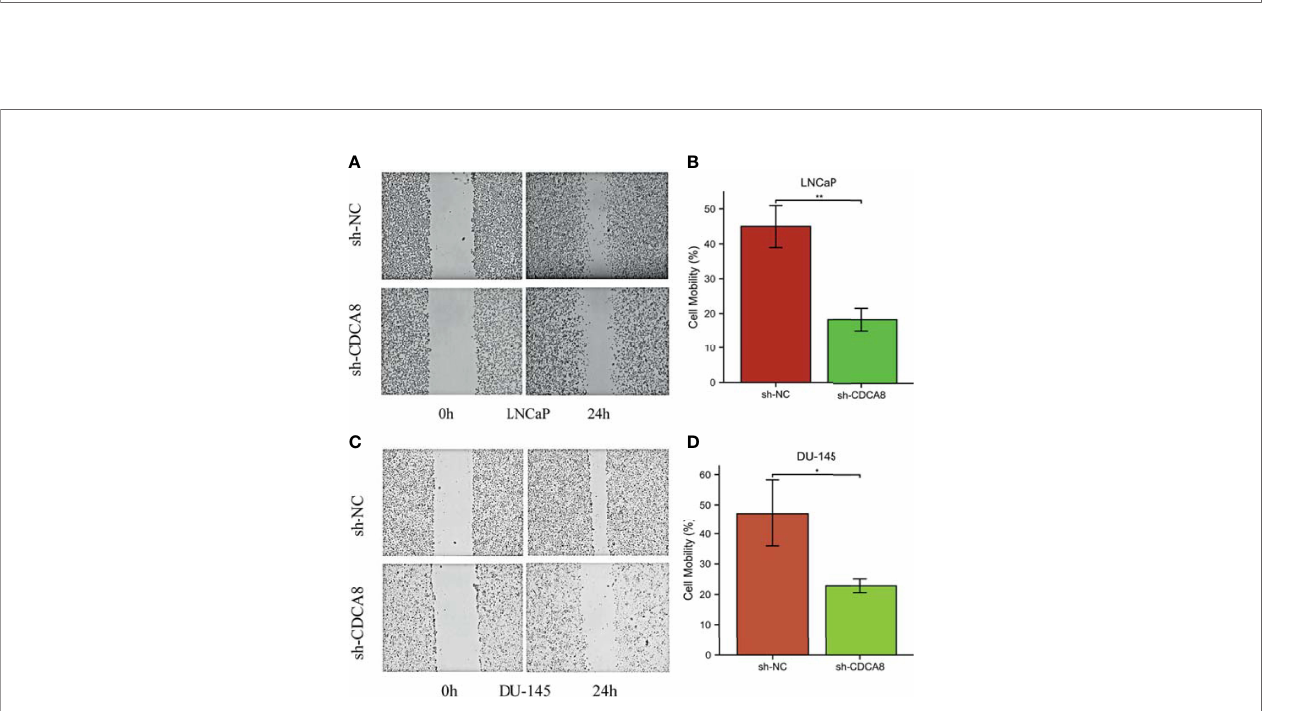
FIGURE 9 | The proliferation ability of PCa cells was signi fi cantly attenuated after the knockdown of CDCA8. (A, B) Cellcountingkit-8 (CCK8) analysis showed that down-regulation of CDCA8 inhibited the growth of LNCaP and DU-145 cells ( ns P > 0.05; *P < 0.05; ***P < 0.001. two-way ANOVA). (C-F) In a colony formation assay, silencing of CDCA8 reduced the number of colonies in LNCaP and DU-145 cells (***P < 0.001 versus sh-NC; two-tailed t-test). NC, negative control.